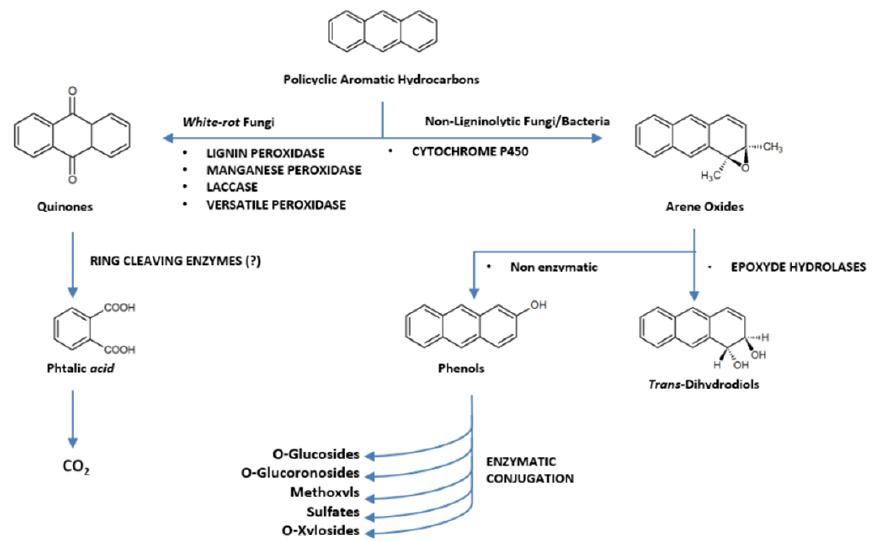
Figure 3. General pathways and enzymes involved in ring cleavage and/or oxidation of poly-cyclic aromatic hydrocarbons.